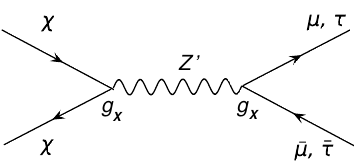
Figure 5. The dominant early-Universe annihilation channel for a predominantly Z 0 -ino LSP.